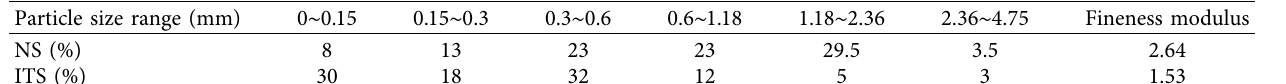
Table 2: Grain size distribution of NS and ITS.